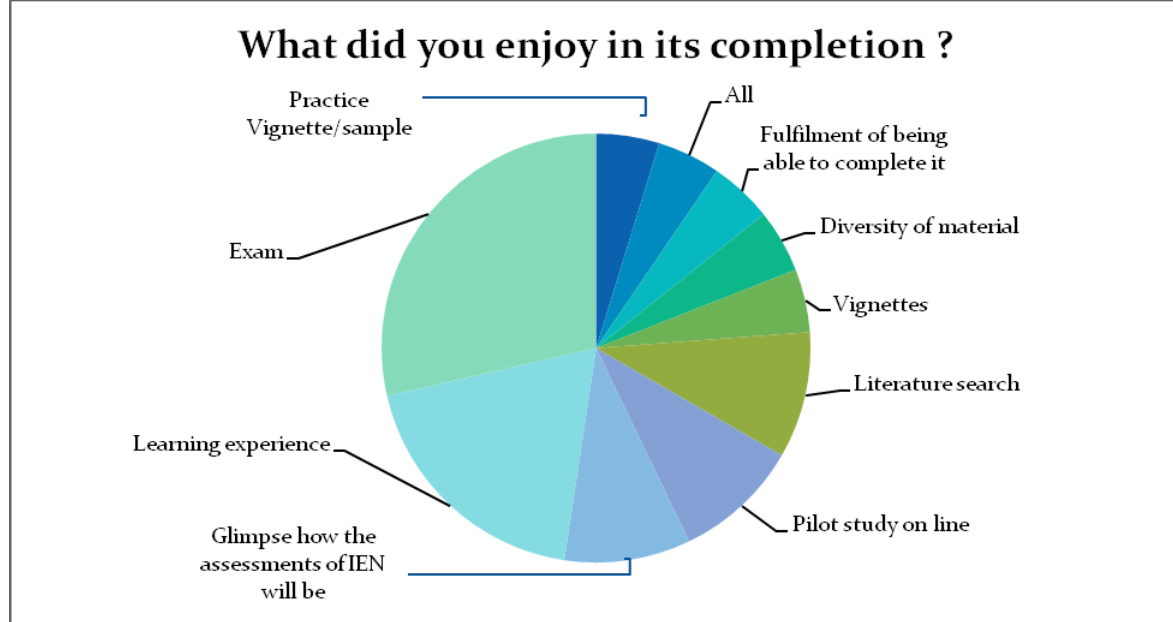
Figure 3 . IEN RN enjoyment of PLAR process.